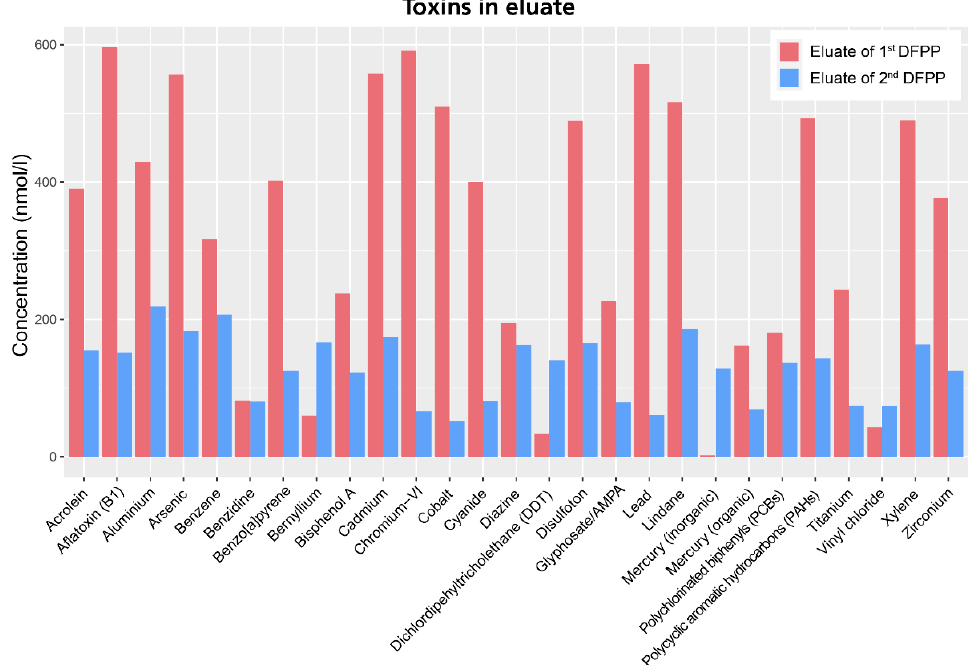
Figure 4. Concentration of toxins detected in the eluate of the first and second DFPP treatment. The first eluate showed a high amount of toxins whereas the amount was significantly reduced in the second eluate, highlighting the ability of DFPP to remove toxins from the blood/tissue.